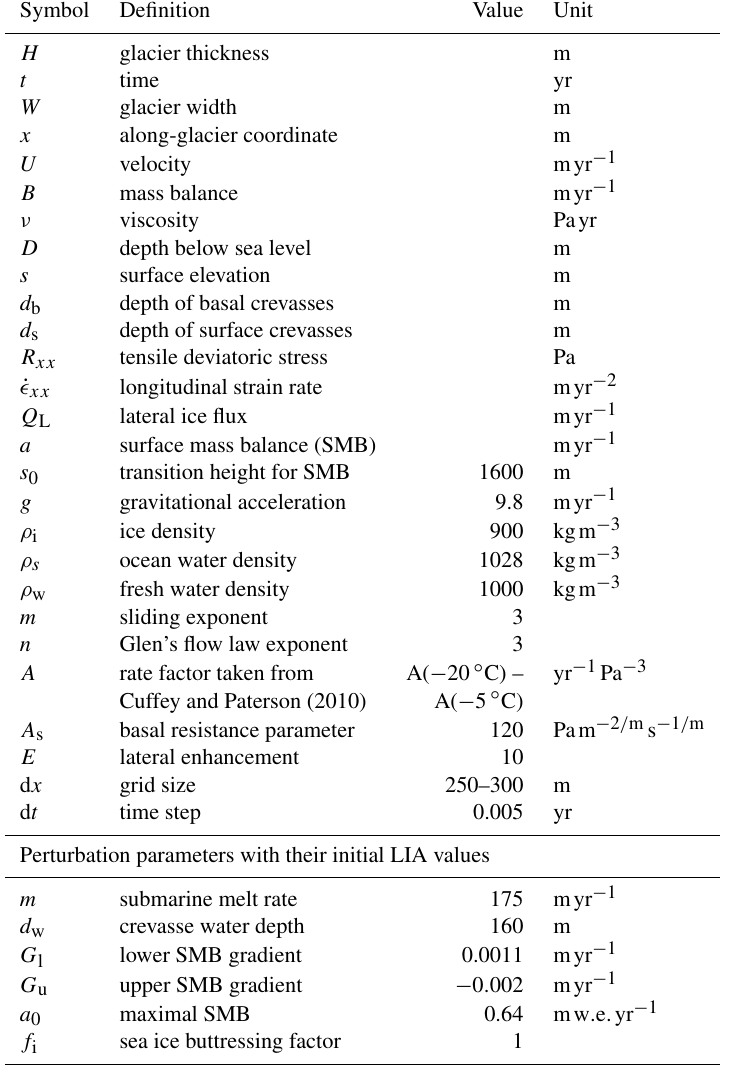
Table 1. List of variables, physical parameters and constants used in the model. The forcing parameters with their initial (LIA) values are given in the lower part. Parameter values used for the glacier retreat experiments are listed in Table